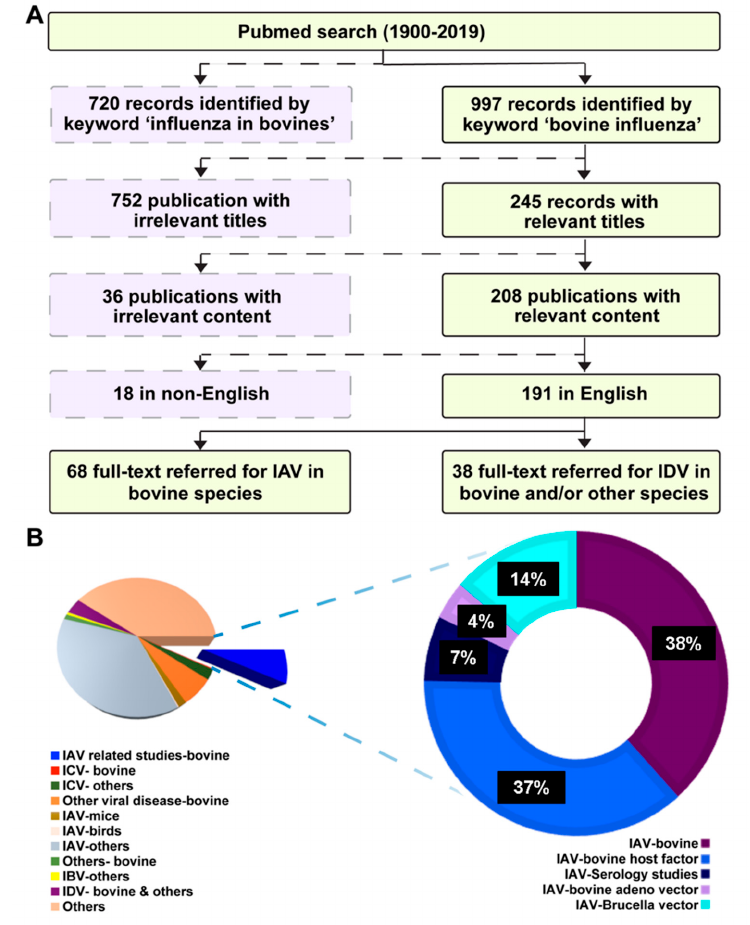
Figure 1. Schematic illustration of the literature search strategy. ( A ) A literature search was conducted using different keyword combinations in the PubMed database. Initial screening was carried out by shortlisting articles that matched the title for topic relevance and the availability of the articles in full text or abstract as shown in the flow chart. ( B ) Articles obtained after the keyword search were categorized based on their content as described in the pie chart. A comprehensive analyses of influenza A related studies in bovines represented by donut chart were conducted. Abbreviations used: Influenza A virus, IAV; Influenza B virus, IBV; Influenza C virus, ICV; Influenza D virus, IDV.